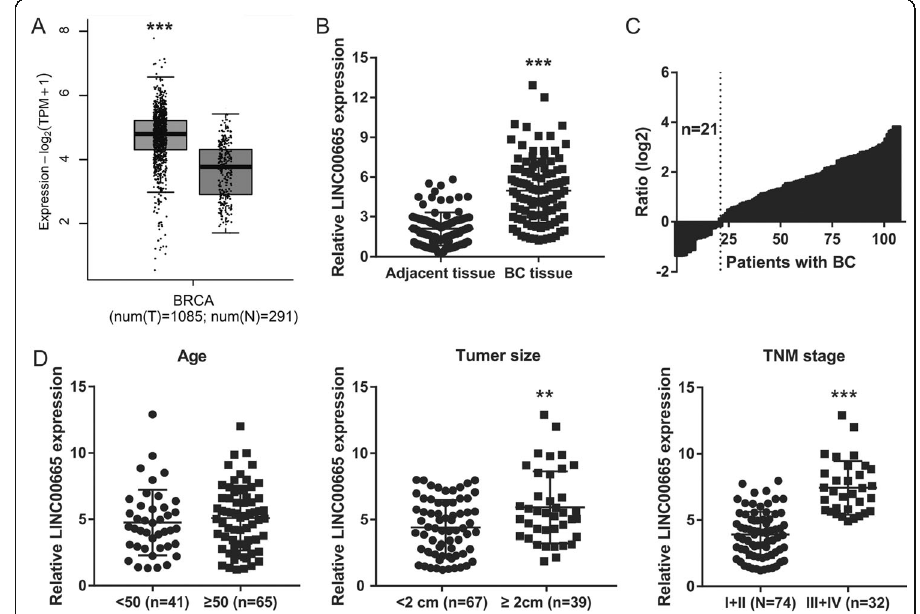
Fig. 1 LINC00665 upregulation in breast cancer (BC) tissues and associations with different patient clinical characteristics. a LINC00665 expression levels in BC tissues ( n = 1085) and normal breast tissues, as analyzed using gene expression profiling interactive analysis (GEPIA, n = 291). b LINC00665 expression in BC tissues and adjacent normal breast tissues, as measured using quantitative reverse transcription-polymerase chain reaction (qRT-PCR). c The number of BC patients (x-axis) versus the distribution plot of the log2 values of the relative expression ratio of LINC00665 in BC tissues to that in adjacent normal breast tissues (y-axis). d Relationships between LINC00665 expression and different patient clinical